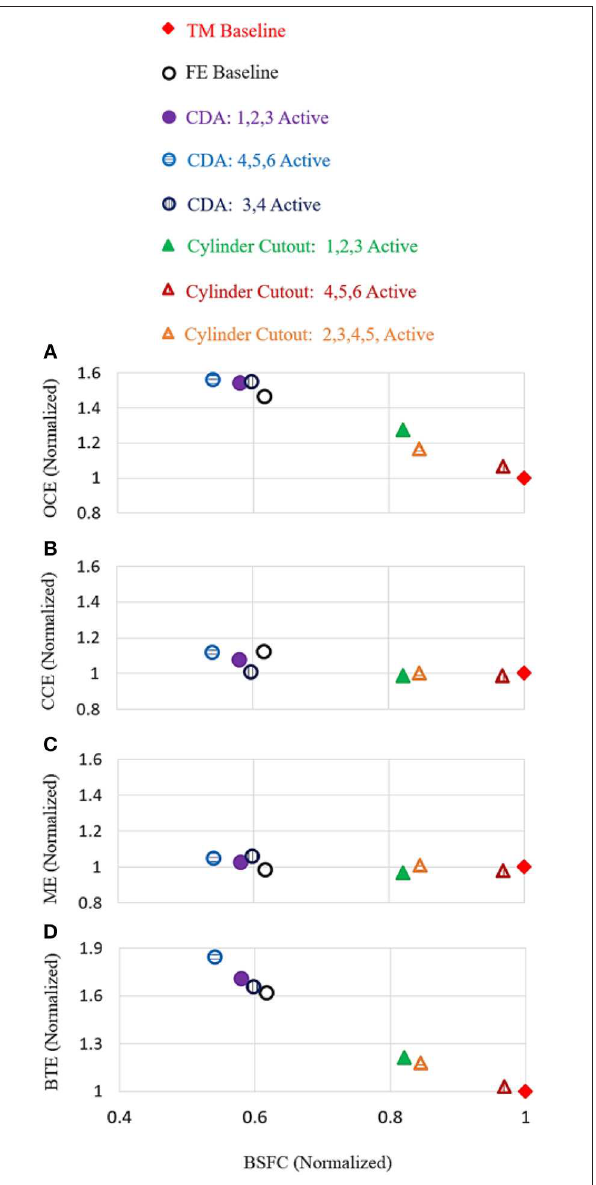
FIGURE 9 | (A) Represents the impact each strategy had on OCE. (B) Represents the impact each strategy had on CCE. (C) Represents the impact each strategy had on ME. (D) Represents the impact each strategy had on the overall